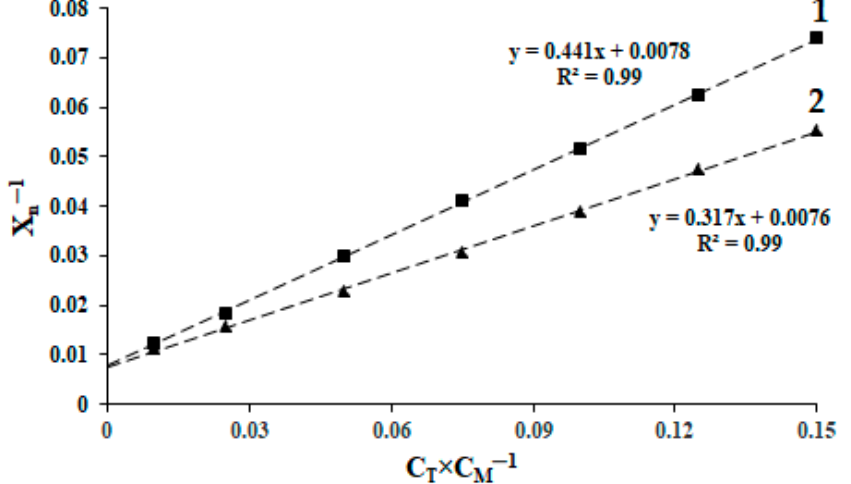
− 1 − 1 Figure 6. Linear dependences X , for radical polymerization of N-vinyl-2-pyrrolidone (cid:2879)(cid:2869) , for radical polymerization of N-vinyl-2-pyrrolidone at (cid:2879)(cid:2869) (cid:1874)(cid:1871). (cid:1829) (cid:1829) Figure 6. Linear dependences (cid:1850)(cid:3364) n vs. C T C M (cid:3041) (cid:3021) (cid:3014) at 343K in the presence of sulfanyletanoic acid—1 and 3-sulfanylpropanoic 343K in the presence of sulfanyletanoic acid—1 and 3-sulfanylpropanoic acid—2. Experimental data indicate a higher activity of sulfanylethanoic acid ( (cid:2019) = 0.317 ). The calculated (cid:2019) compared to 3-sulfanylpropanoic acid ( (cid:2019) (cid:3021) sistent with a greater stabilization by the inductive effect of the carboxyl group of the rad- ical formed from sulfanylethanoic acid, as compared to its homologue formed from 3- sulfanylpropanoic acid. Probably for this reason, the rate of polymerization of N-vinyl-2- pyrrolidone in the presence of sulfanylethanoic acid is somewhat higher than with the addition of 3-sulfanylpropanoic acid. The high value of (cid:2019) (cid:3021) make it possible to achieve selectivity with respect to end groups for telomers of N-vinyl-2-pyrrolidone formed in the presence of mercapto acids. The 13 C NMR spectrum of the telomer of N-vinyl-2-pyrrolidone has a signal of 176.65 ppm., which corresponds to the terminal carboxylate and is clearly distinguishable against the background of the signal, in the range of chemical shifts 176.92–177.30 ppm, which belongs to the amide group of N-vinyl-2-pyrrolidone residues of various configurations. In addition, the chemical shift region is 115–125 ppm. does not contain signals character- istic of carbon atoms of the nitrile group, which indicates an insignificant contribution of the processes of interaction of the monomer and radicals formed directly during the de- composition of AIBN to the formation of polymer chains. The position and structure of the remaining signals in the 13 C NMR spectrum of the synthesized telomere of N-vinyl-2- pyrrolidone correspond to their assignment (Figure 7), considering the various configu- rations of chain links described earlier in the article [40].